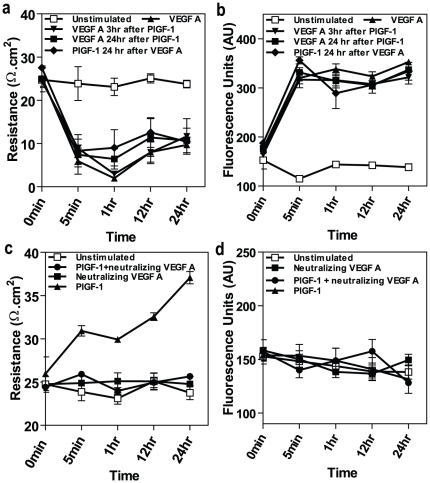
The effect of PlGF-1 on VEGFA-induced permeability is highly dependent on the timing and order of exposure.(a) Effect of VEGFA alone, hPlGF-1 pretreatment for 3 hr or 24 hr exposure to VEGF and hPlGF-1 24 hours post VEGF on temporal changes in transendothelial resistance across a microvascular endothelial monolayer grown on a transwell insert effected by (n = 4 independent experiments). VEGFA and hPlGF-1 were used at 100 ng/ml. (b) paracellular macromolecular permeability to 40 kDa Dextran-FITC using the conditions described in (a) (n = 4 independent experiments). (c) The effect of neutralization of endogenous VEGF on PlGF-induced transendothelial resistance (n = 4 independent experiments). VEGFA neutralizing antibody was used at 10 µg/ml. (d) Paracellular macromolecular permeability to 40 kDa Dextran-FITC using the conditions described in (c) (n = 4 independent experiments). Data are represented as means ± s.e.m. *p<0.05, ** by p<0.01 (Student's t test and ANOVA for multiple comparisons).